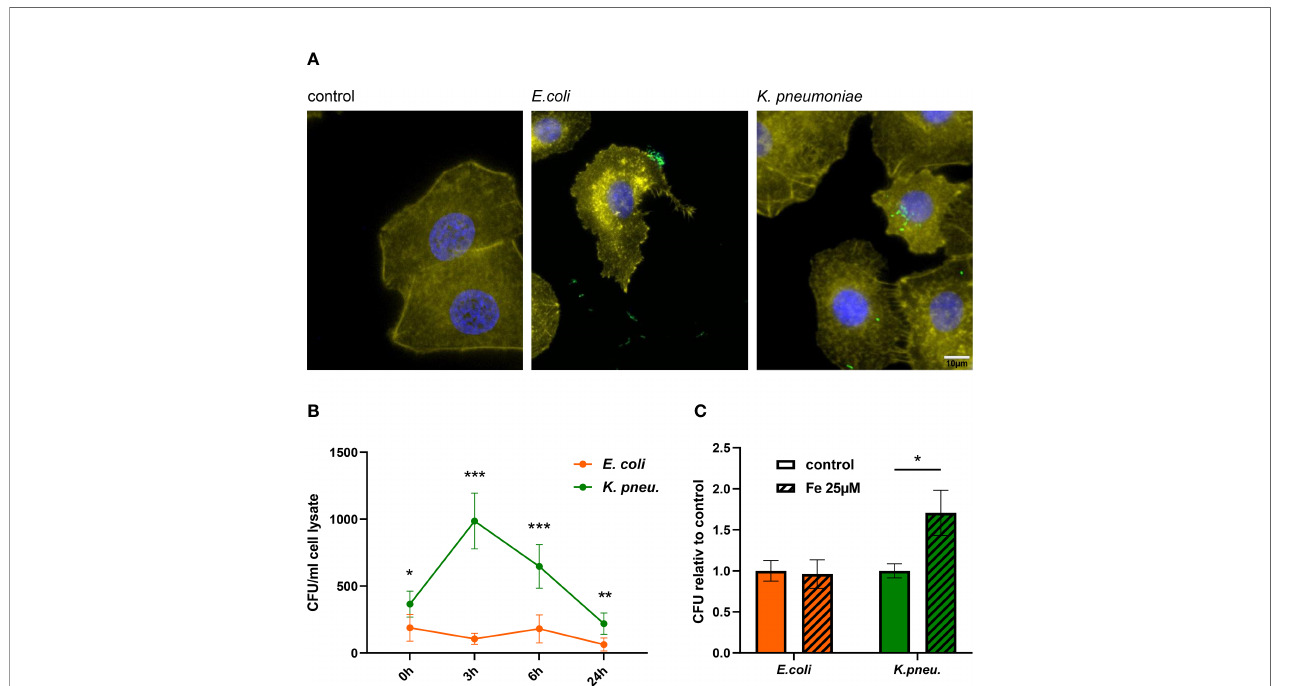
FIGURE 1 | Immune fl uorescence imaging reveals the predominant localization of bacteria: E. coli in the extracellular space and K. pneumoniae in the intracellular space of A549 cells (A) . Representative images, showing Ypet expressing bacteria (green) infecting A549 cells (DAPI= blue, phalloidin= yellow) at 400x magni fi cation with a 10µm scale bar. Time course of bacterial load (recovered intracellular CFU) in A549 cells (B) . A549 cells were infected with E. coli or K. pneumoniae for 2h at MOI of 10 and were lysed directly after incubation phase (0h time point) or at noted time intervals of intracellular infection. Lysates were plated onto LB-agar plates for CFU quanti fi cation. Data are shown as mean CFU/ml lysate ± 95% CI of three separate experiments.Intracellular bacterial load increases in K. pneumoniae infected, iron-loaded cells (C) .A549 cells were stimulated with 25µM iron (III) nitrate nonahydrate 3h before infection. Cells were infected with either E. coli or K. pneumoniae at MOI of 10 for 2h in fresh iron-adequate medium. Subsequently, cells were washed thoroughly and further incubated in gentamicin-containing medium ± 25µM iron(III) nitrate nonahydrate for 6h, until cells were lysed, and intracellular bacteria plated for CFU quanti fi cation. Data from three separate experiments are shown as mean ± SEM, normalized to the corresponding control condition. * denotes p<0.05, ** denotes p<0.01, *** denotes p<0.001 for post-hoc statistical testing. CFU, colony-forming-units ; K. pneu ., K .